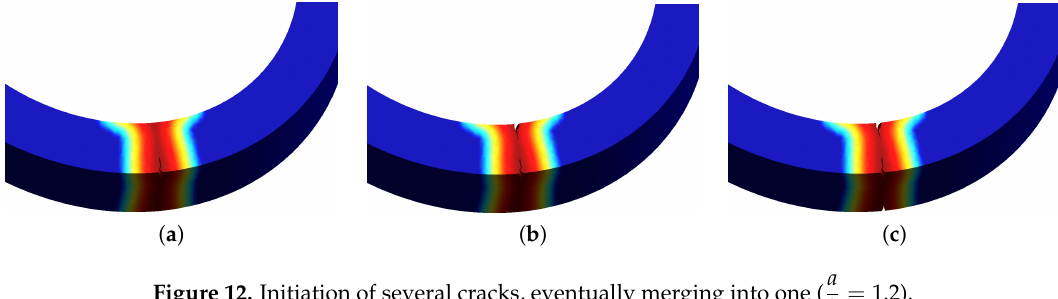
Figure 12. Initiation of several cracks, eventually merging into one (